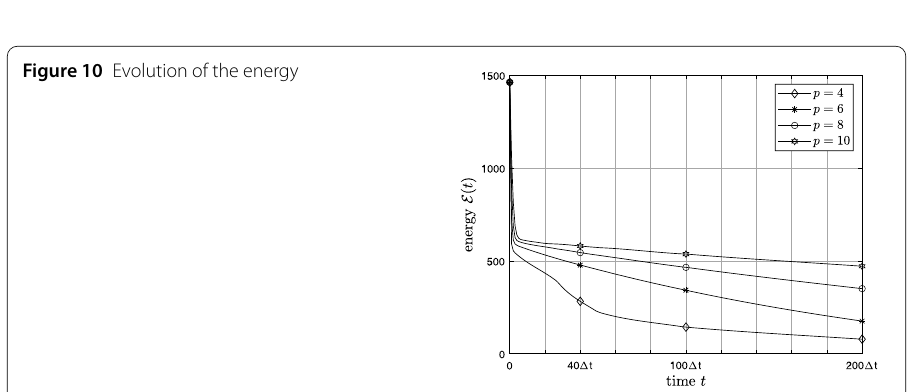
, (cid:4) = (cid:7) x , and (cid:7) t = 10 (cid:4) 2 64